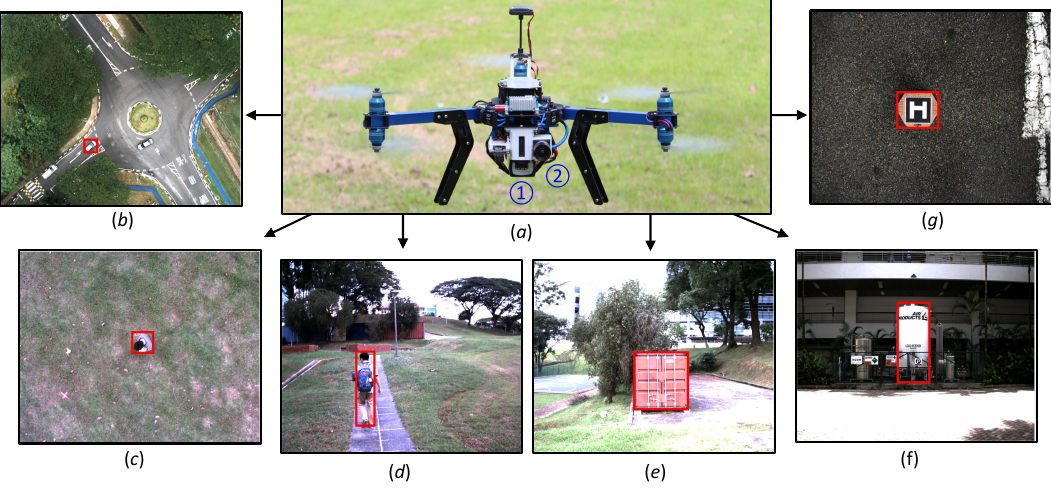
Figure 5. Robust real-time accurate long-term visual object tracking onboard our Y6 coaxial tricopter UAV. No. 1 and 2 in ( a ) show downward- and forward-looking monocular RGB cameras. Some 2D or 3D objects with their tracking results are shown in ( b – g